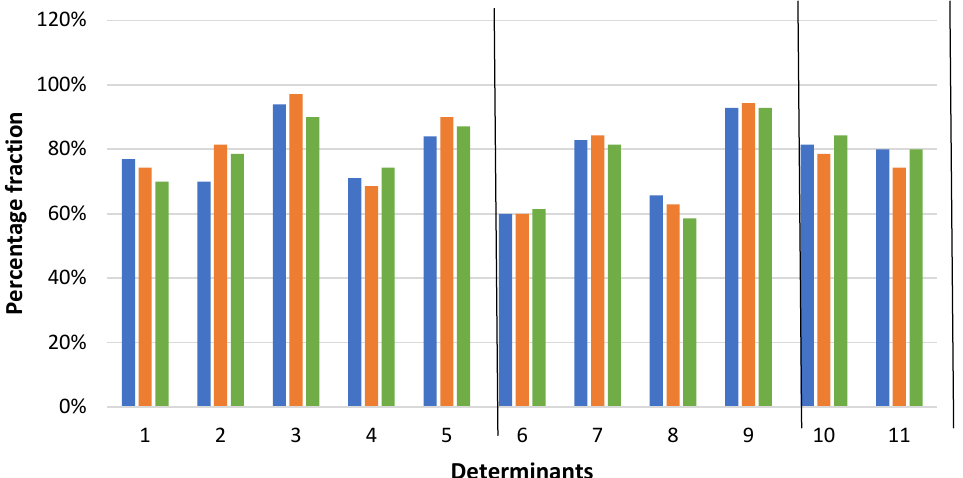
Figure 4. Aggregated results for the SERVPERF method.